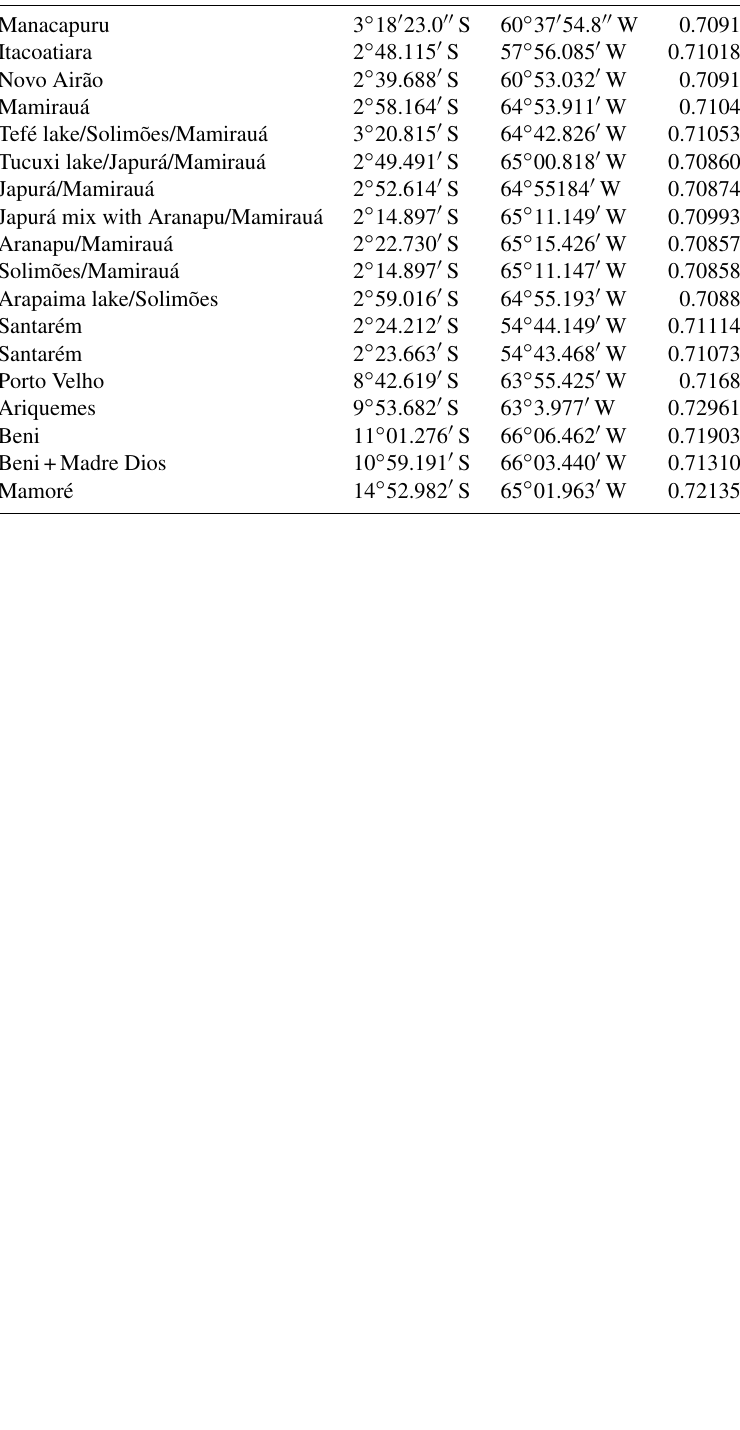
Table A1. Mean ± SD dissolved 87 Sr / 86 Sr for 18 amazonian sites. Local